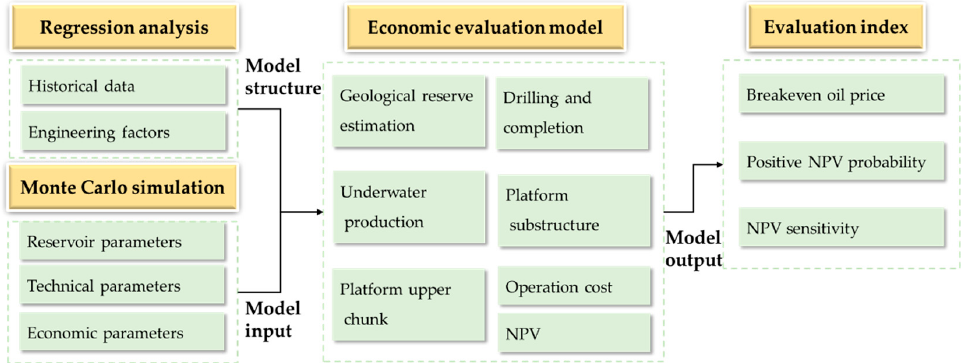
Figure 3. Diagram of the realistic and integrated evaluation method.